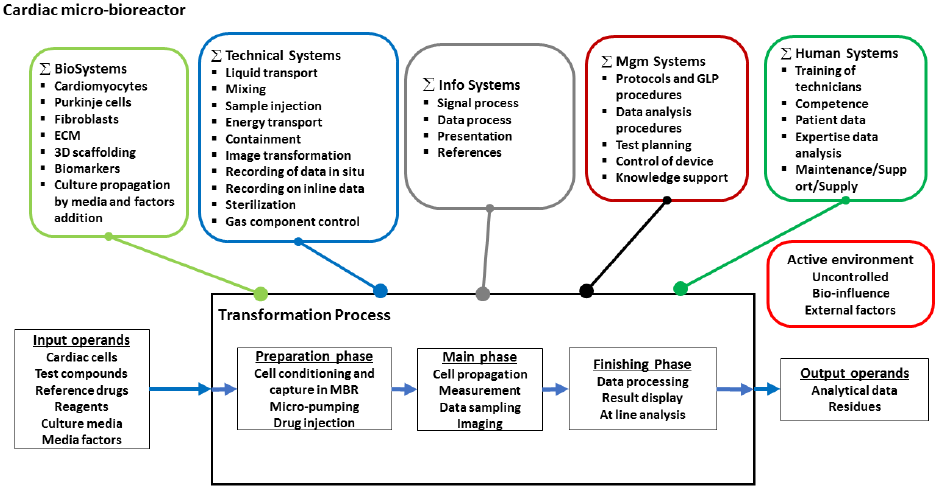
Figure 8. Hubka-Eder map showing the functional systems and subsystems that could be involved in a heart-on-a-chip MBR for purposes indicated in Table 5.